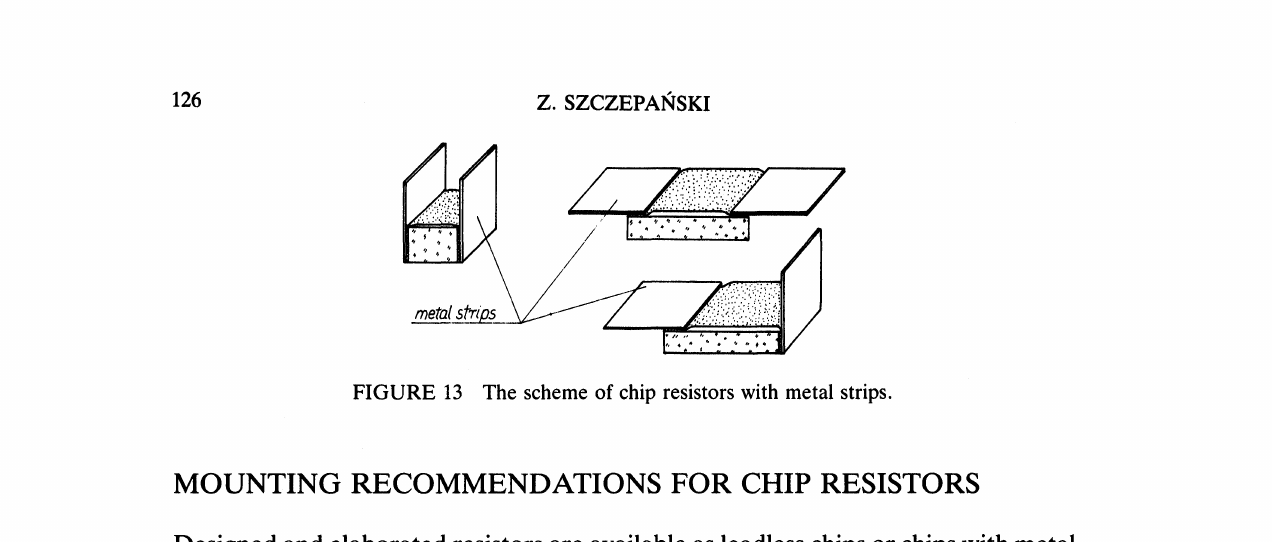
FIGURE 13 The scheme of chip resistors with metal strips.